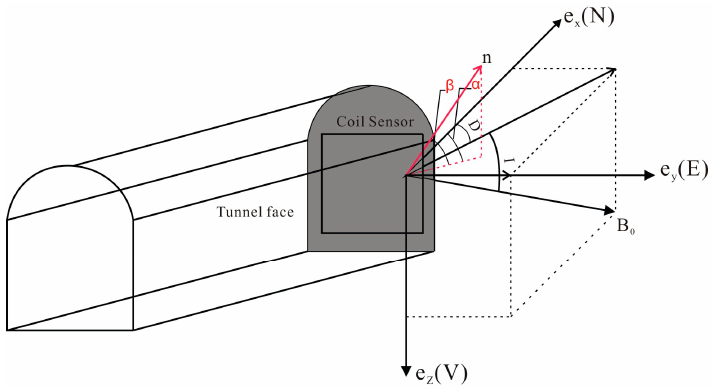
Figure 1. Schematic diagram of underground magnetic resonance sounding (MRS) excitation field and geomagnetic field.